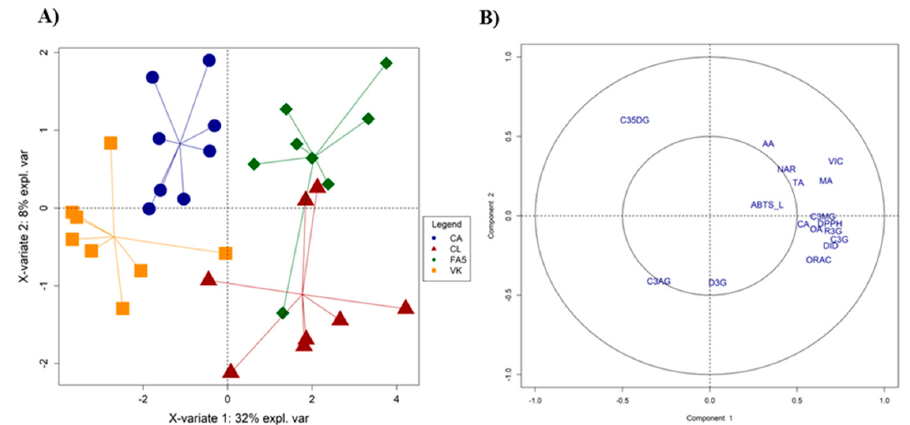
Figure 2. ( A ) ML-PLS-DA scores plot of two first components performed on ‘Sanguinelli’ orange samples to evaluate the rootstock effects. Color and figure indicate the rootstocks: red triangles for ‛ Cleopatra mandarin’ (CL), blue circles for Carrizo citrange (CA), yellow square for Citrus volkameriana (VK), and green diamond for Forner-Alcaide no.5 (FA5). ( B ) ML-PLS-DA loadings plot of the compounds selected in the iteration procedure in `Sanguinelli´ orange samples. Abbreviations: